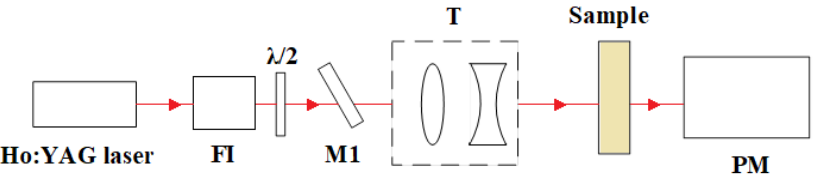
Figure 1. Optical layout of the experimental setup for the study of the Cr 2+ :ZnSe optical damage.